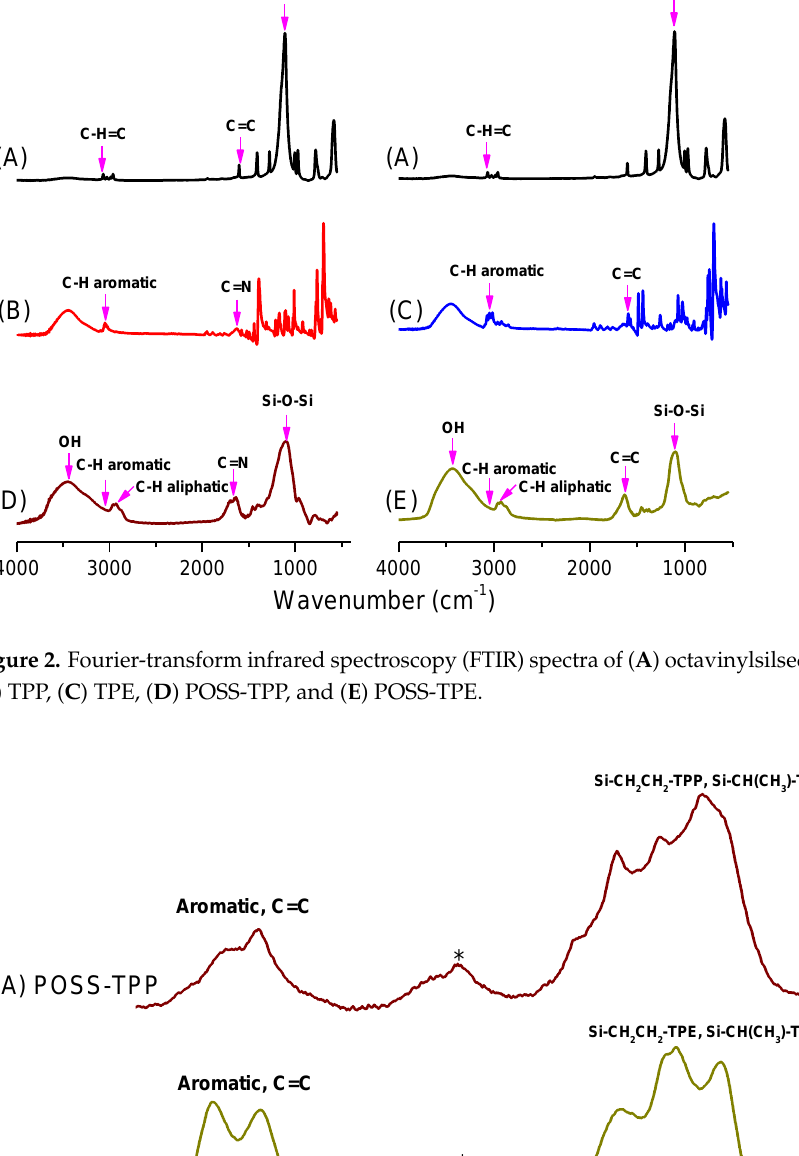
Figure 3. Solid-state 13 C CP/MAS NMR spectra of the states of ( A ) POSS-TPP and ( B ) POSS-TPE, where * is the side band of solid state nuclear magnetic resonance spectroscopy (NMR).